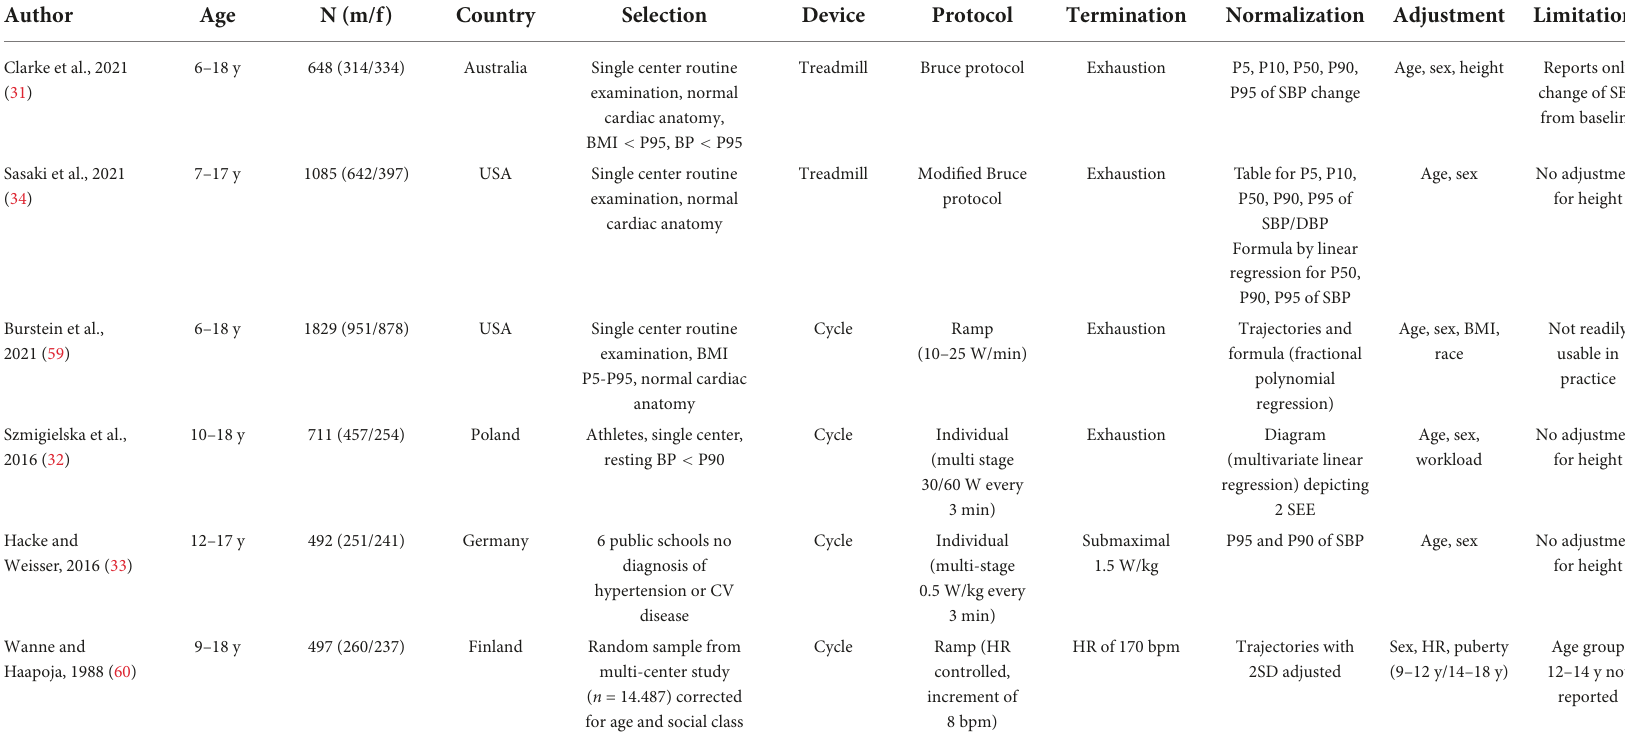
TABLE 1 Overview of studies reporting reference values for blood pressure during exercise testing in